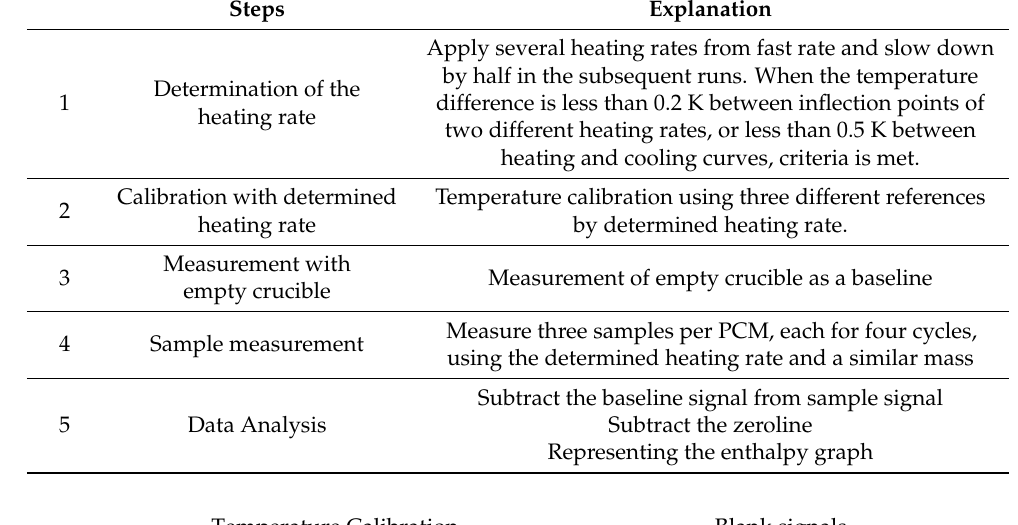
Table 7. IEA method to determine enthalpy [7,59].